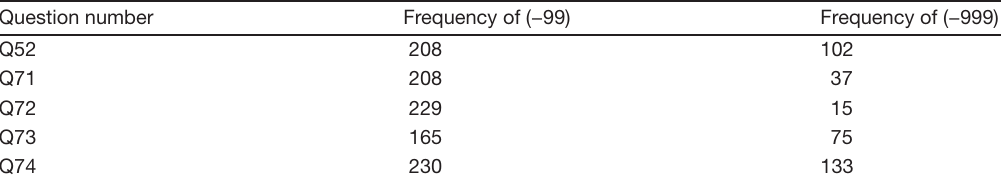
Table A3. Number of missing data cells (−99) and cells where answers were scored neutrally as difficult to interpret (−999) by